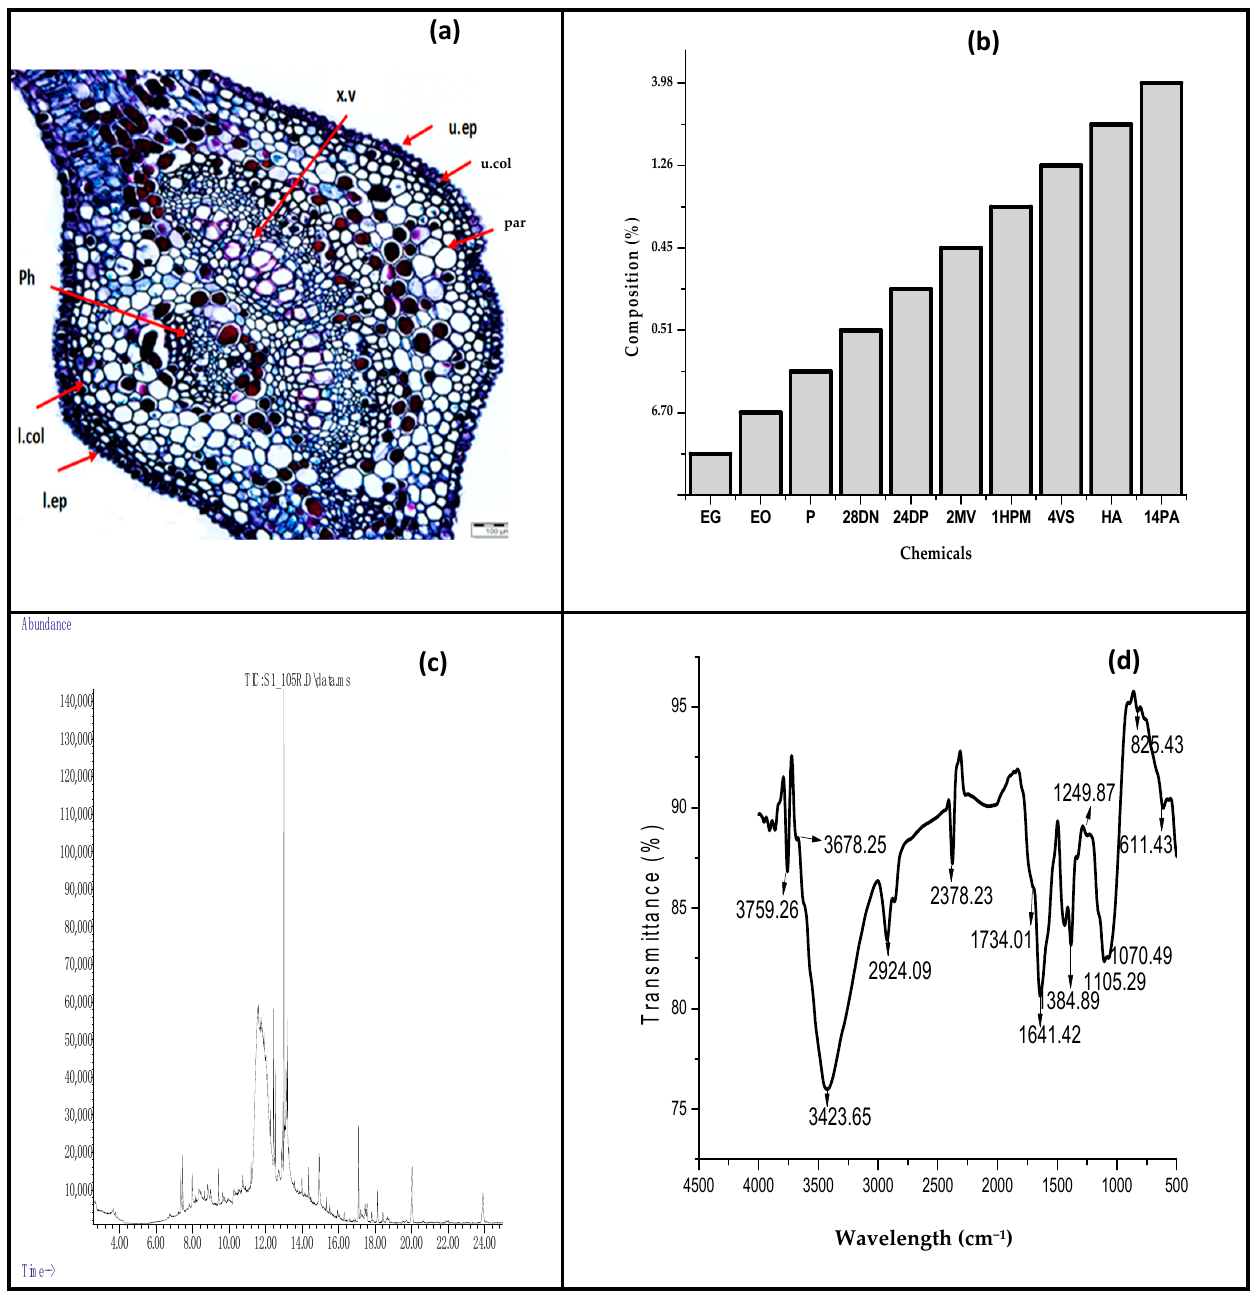
Figure 1. ( a ) Cross section of the leaf of Azadirachta indica. Magnification: 40X. col., collenchyma; ep., epidermis; x.v., xylem vessel; Ph., phloem; par., parenchyma; u.ep., upper epidermis; l.ep., lower epidermis; u. col., upper collenchymas; l. col., lower collenchymas; ( b ) chemical composition of ethanol crude neem extracts; EG represents Ethyl.alpha.-d- glucopyranoside, EO illustrates Ethyl 9, 12, 15-octadecatrienoate, P indicates Phytol. Similarly, 28DN represents 28-Deoxo- Nimbolide, 24DP represents 2,4-Dimethoxyphenol, 2Mv illustrates 2-Methoxy-4-vinylphenol and 1HPM, 4V5, HA and 14PA represent 1H-Pyrrole, 4-vinyl-syringol, Hexadecanoic acid, and 14-Pentadecenoic acid, respectively; ( c ) GC-MS analysis which identified different organic compounds from the ethanol crude extract of neem leaves; ( d ) FT-IR spectra of Neem leaves fine powder.